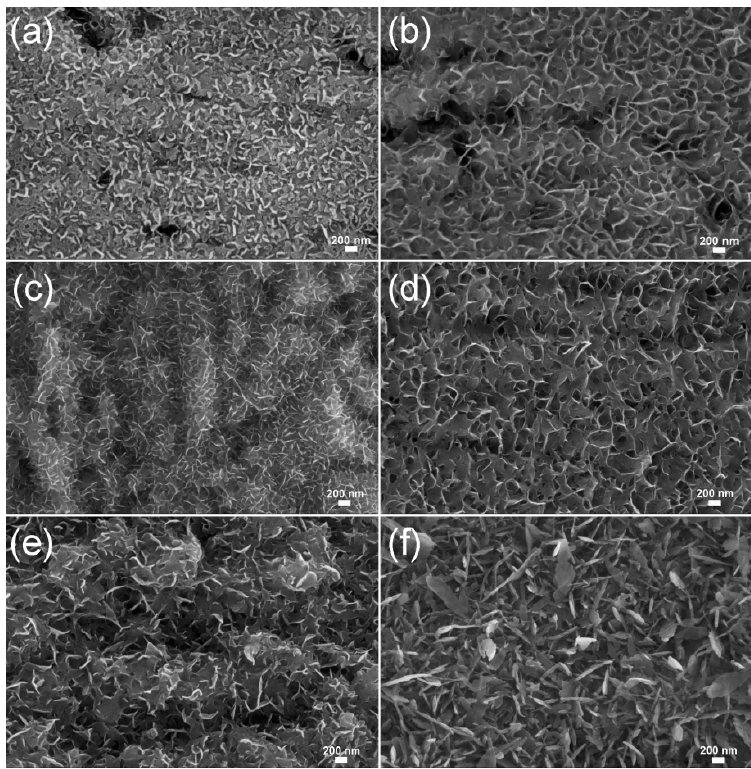
Figure 2. SEM images of the as-prepared Cu 2 O surface on copper mesh with different reaction times: